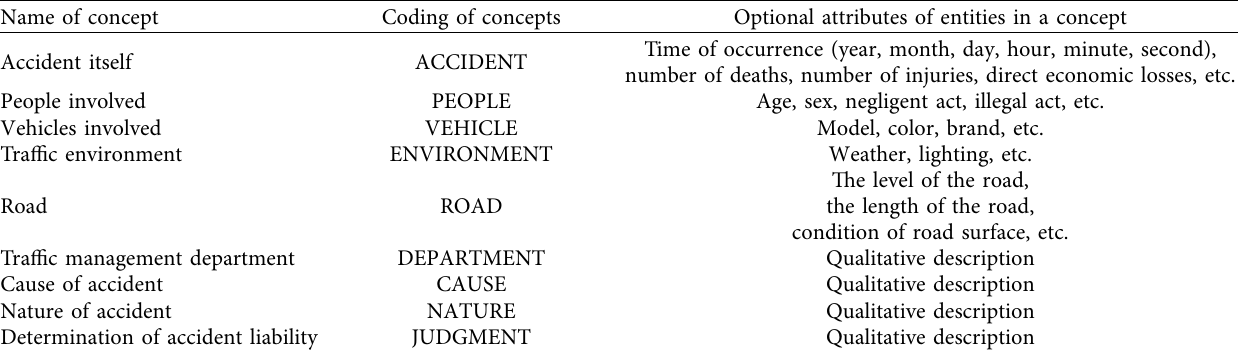
Table 1: Core concepts in the field of traffic accidents.